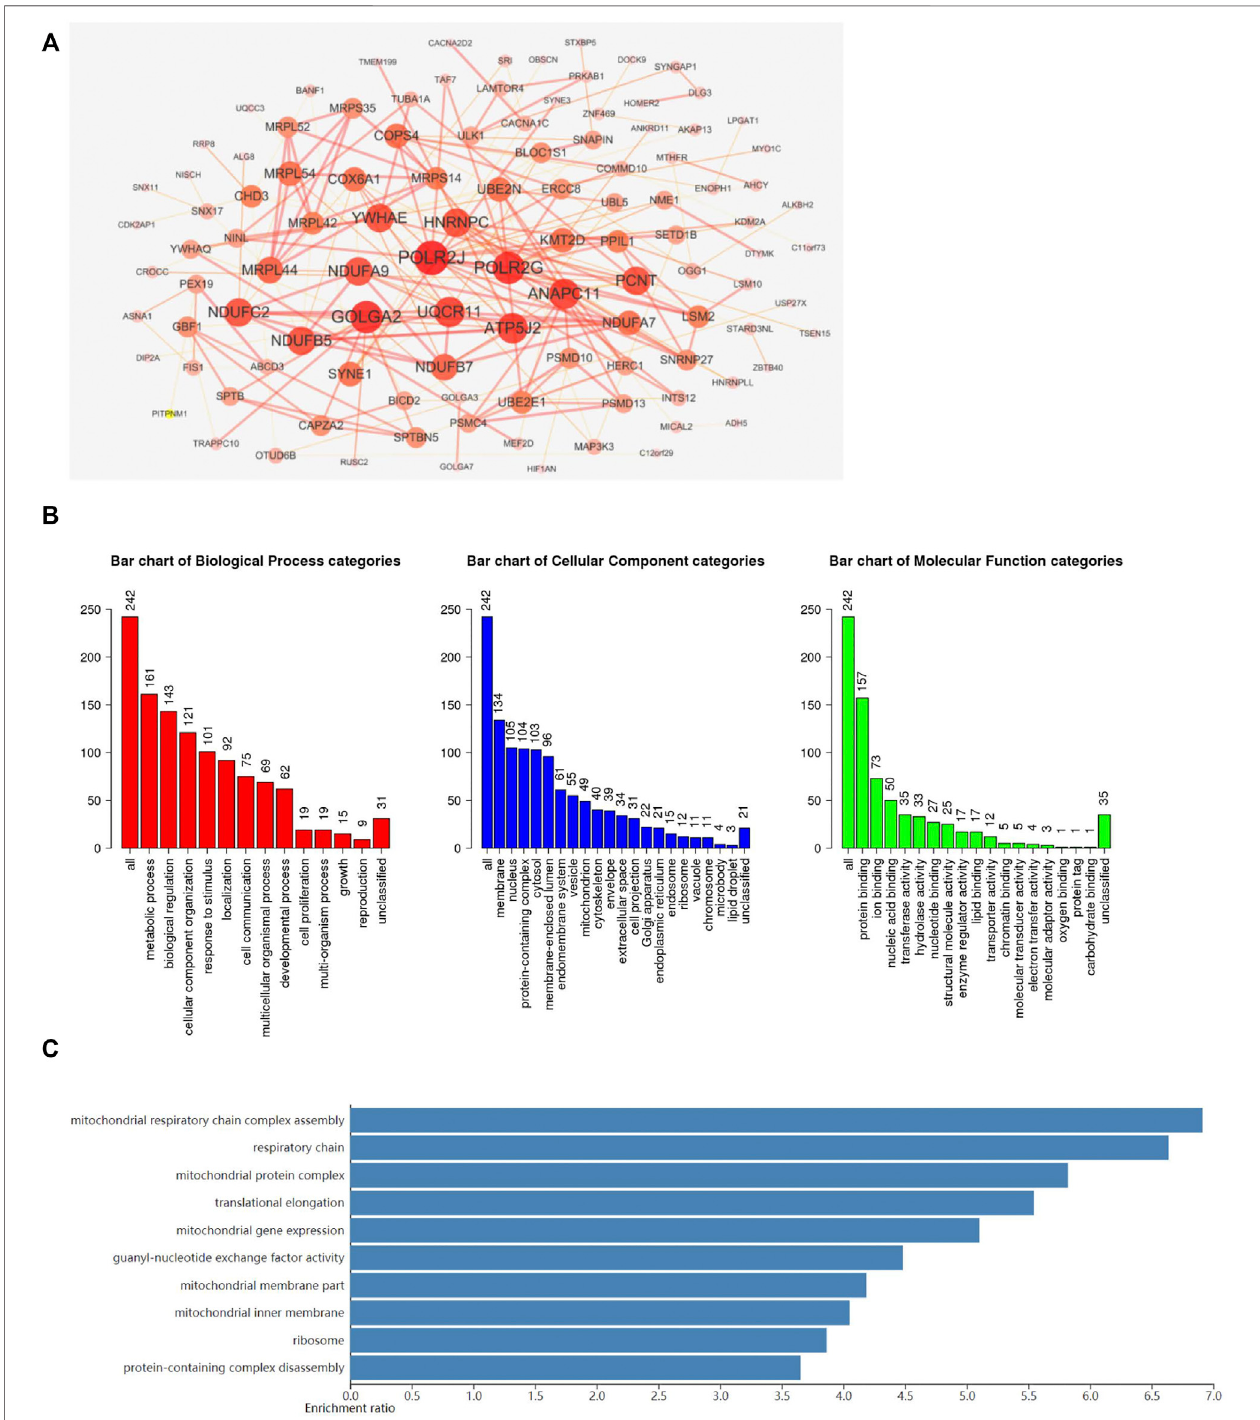
FIGURE 4 | Functional enrichment analysis of ADARB1-associated co-expressed genes. (A) The PPI network of ADARB1 associated co-expressed genes was createdbytheSTRING and Cytoscape software. (B) TheGOanalysisofADARB1associatedco-expressed genes,including biologicalprocesses, cellular components and molecular function. (C) The KEGG pathway analysis of ADARB1 associated co-expressed genes.